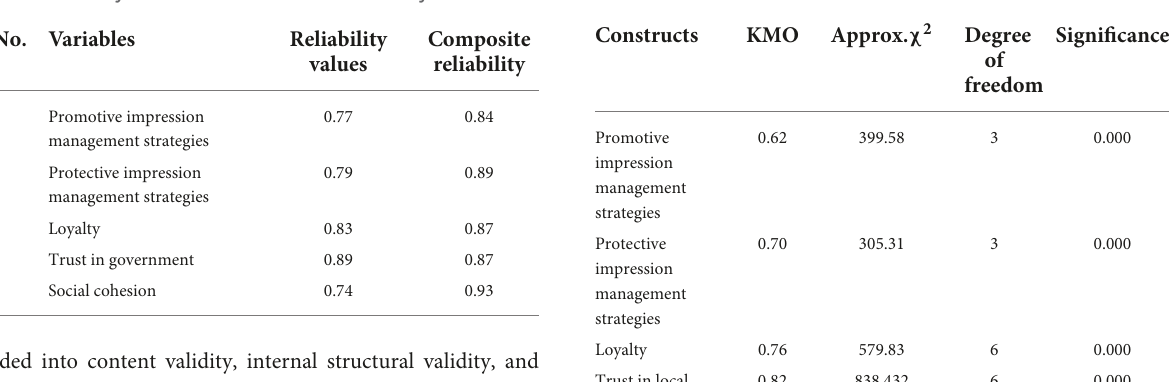
TABLE 2 Reliability table for each construct in this study. TABLE 3 KMO and Bartlett’s